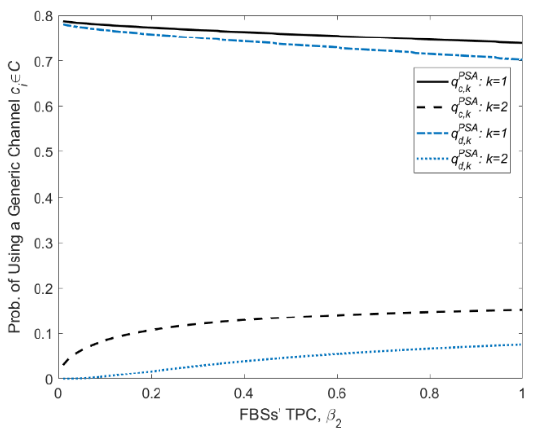
Figure 4. The impact of the FBSs’ TPC (i.e., 𝛽 2 ) on the 𝑞 𝑐,𝑘PSA and 𝑞 𝑑,𝑘PSA in the underlay in-band D2D mode. D2D